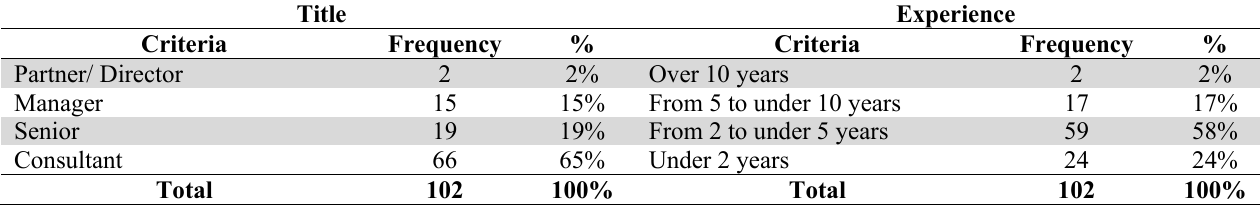
Experiences and titles of survey subjects